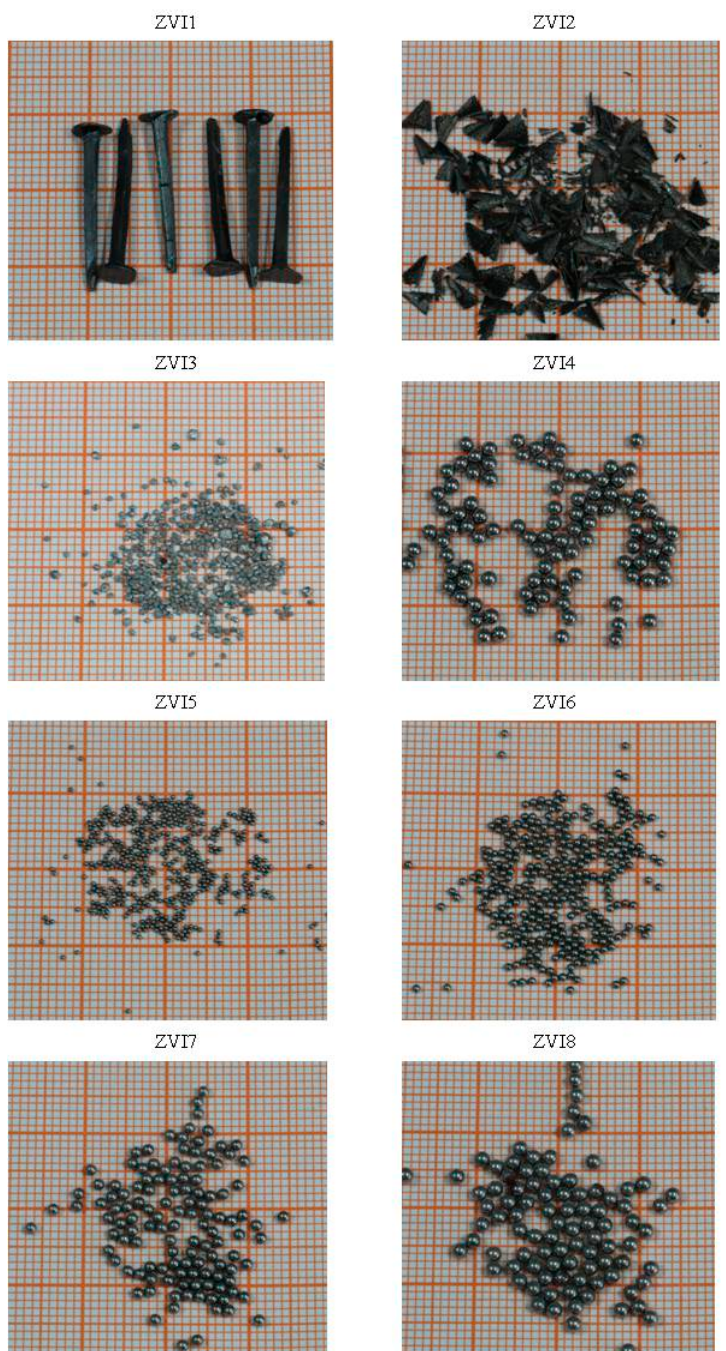
Figure 1. Photographs of the eight tested metallic iron materials. Apart from iron nails (ZVI1), 500 mg of each material was put on a graph paper. Distances of lines in the background are 1 mm in vertical and horizontal directions.